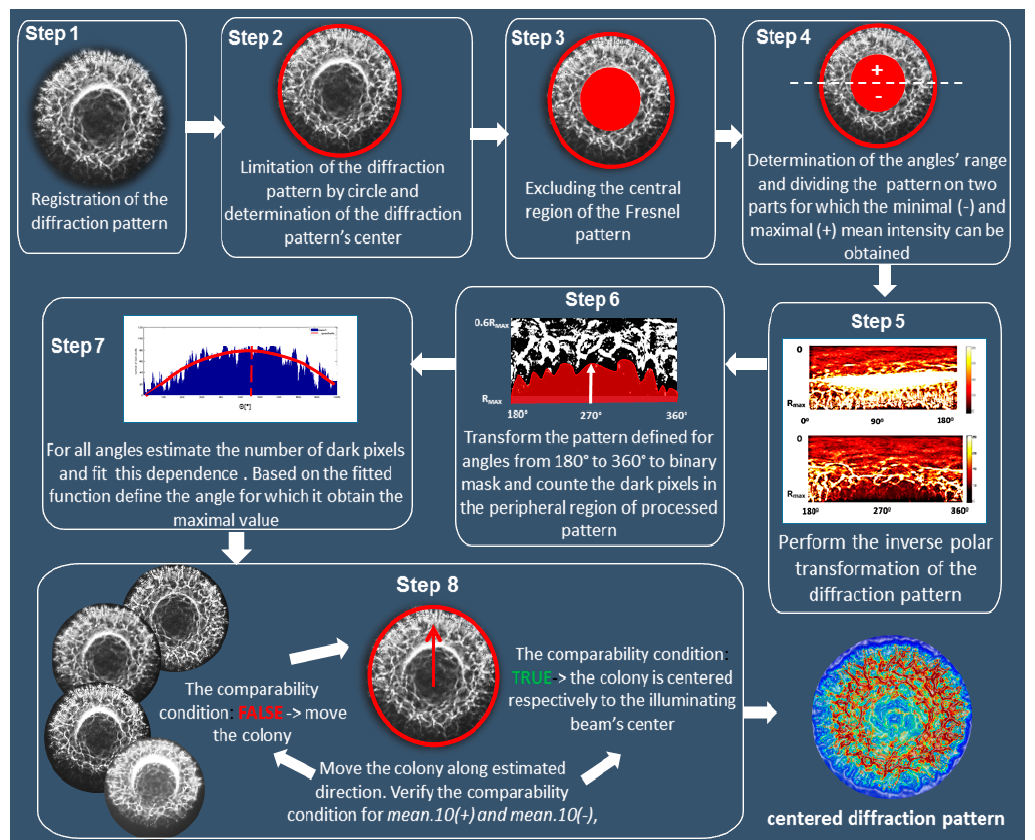
Figure 3. The concept of the image-guided algorithm for automatic positioning of bacterial colony relative to the center of the illuminating beam.